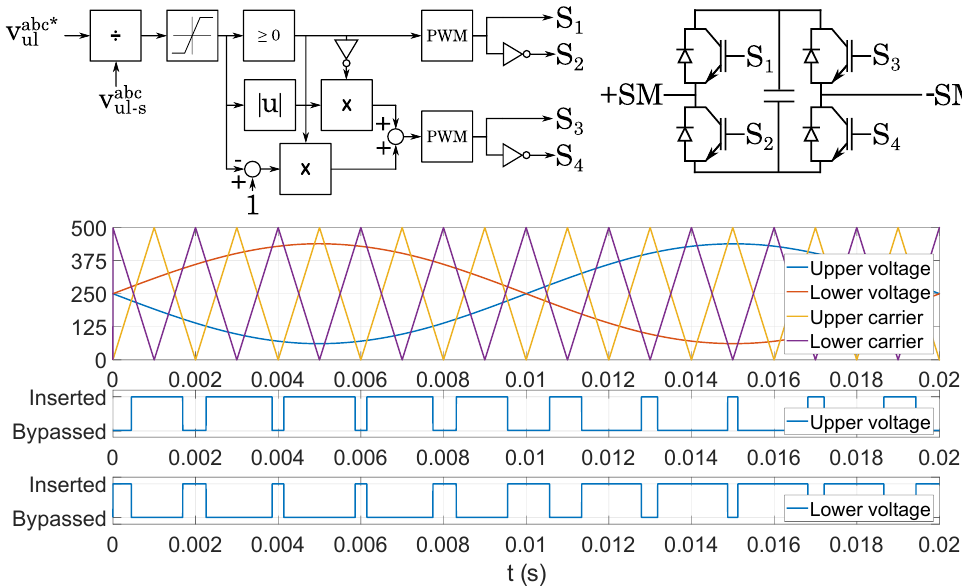
Figure 9. Modulation logic implemented and example results.